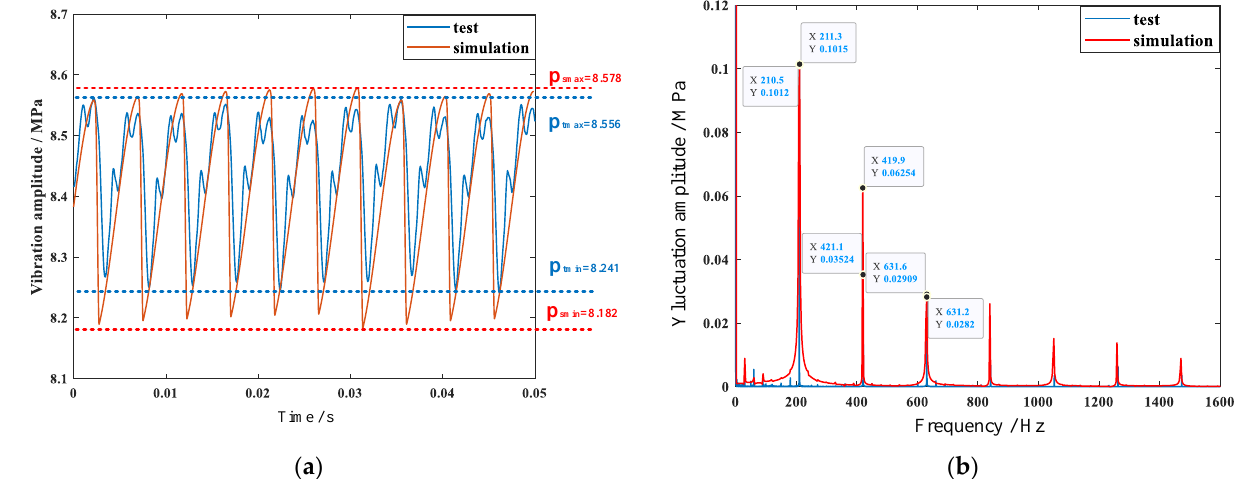
Figure 16. Comparison of simulation and experiment results. ( a ) Time domain comparative analysis chart; ( b ) frequency domain comparative analysis chart. Table 7. Comparative analysis of the fluid pressure fluctuation value and pressure fluctuation rate.